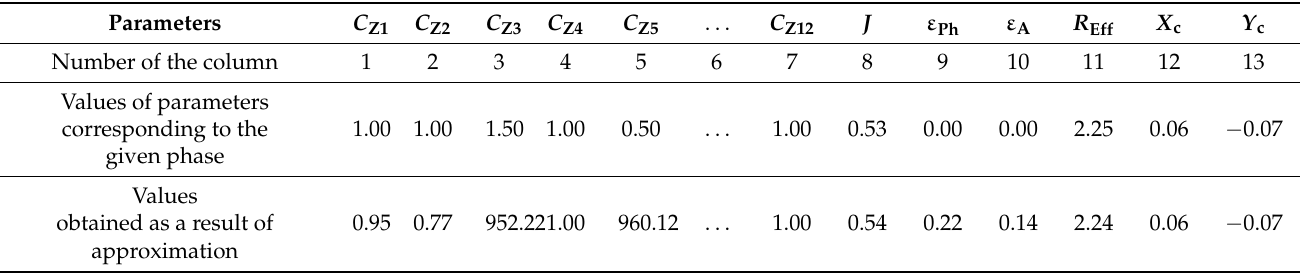
Table 4. The screen was set by 12 polynomials and approximated by 12 polynomials. Dimensions of computational grid are 2048 × 2048 nodes.